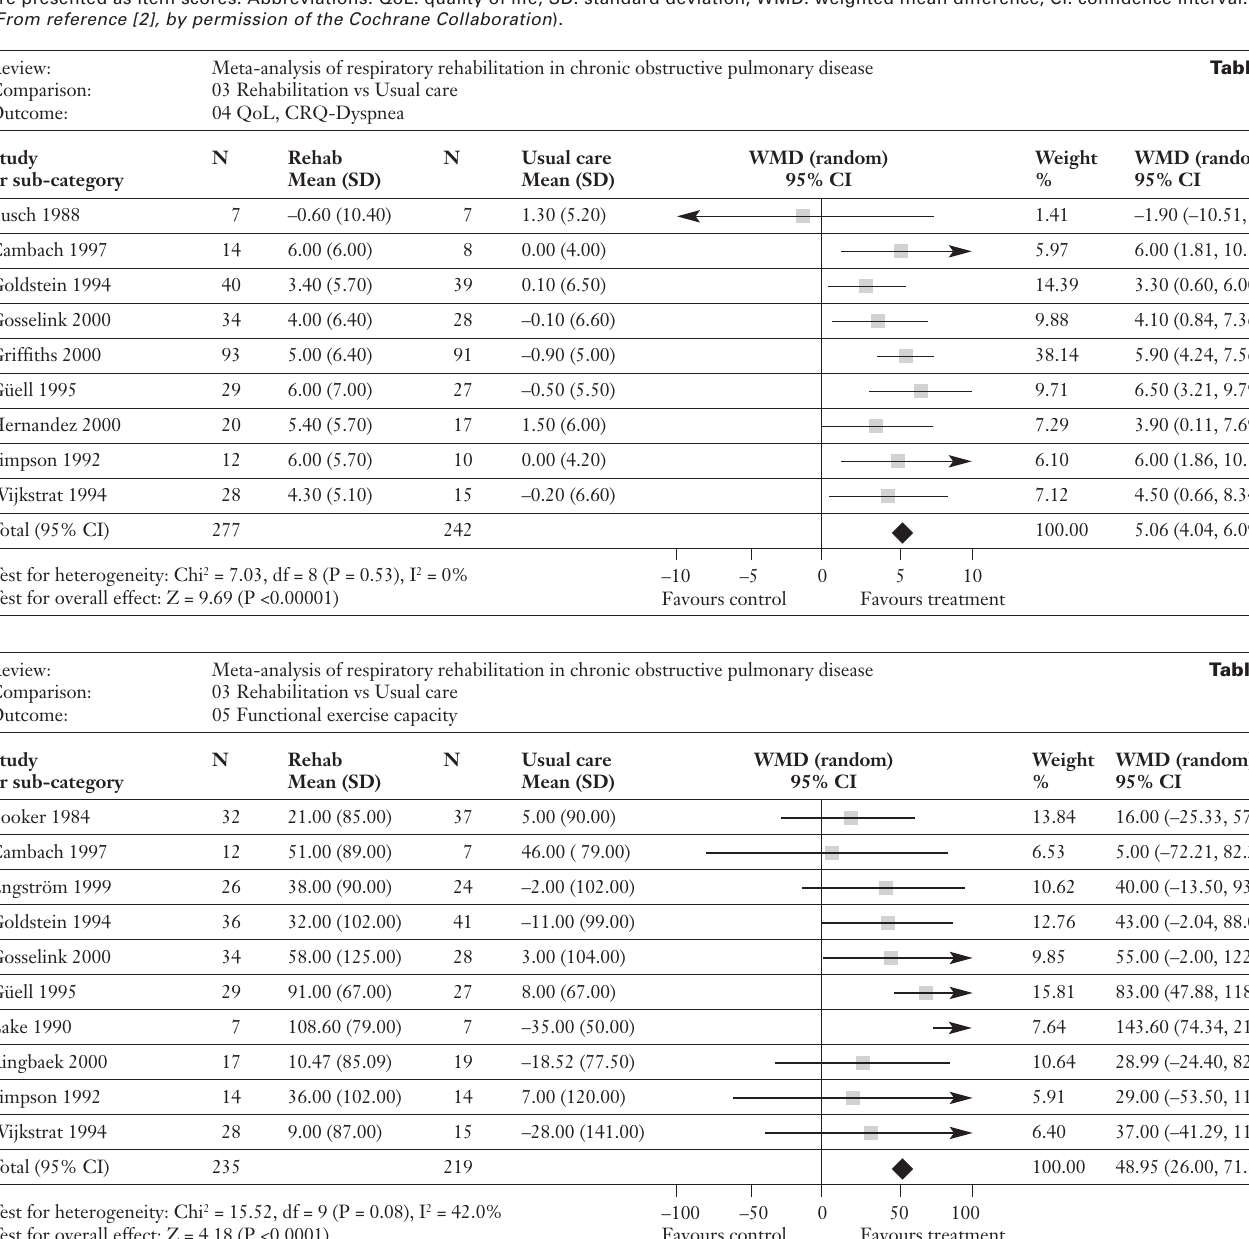
The effect of respiratory rehabilitation in chronic obstructive pulmonary disease on (a) dyspnoea as measured by the Chronic Respiratory Question- naire and (b) functional exercise capacity as measured by the 6-minute walk test: meta-views. The Chronic Respiratory Questionnaire results are pre- sented as the domain total score (5 items graded on a 7-point scale; maximal score = 35), as opposed to the treatment effect values in table 1 which are presented as item scores. Abbreviations: QoL: quality of life; SD: standard deviation; WMD: weighted mean difference; CI: confidence interval. (From reference [2], by permission of the Cochrane